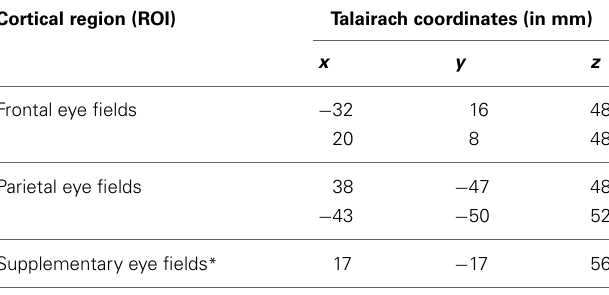
Table 2 | Anatomical locations of regions of interest in the left and right